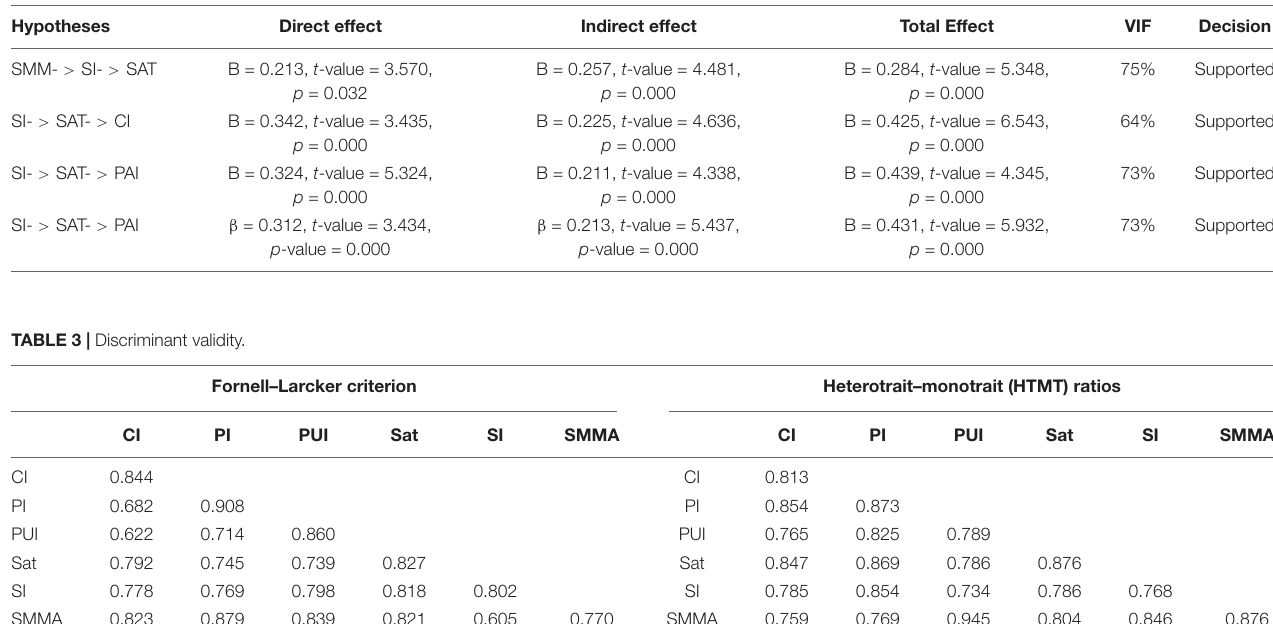
TABLE 2 | A mediation analysis.